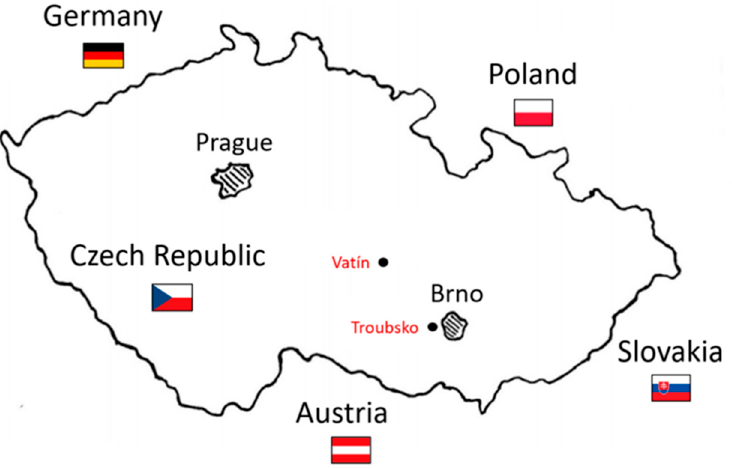
Figure 2. Localization of experimental sites in the Czech Republic.